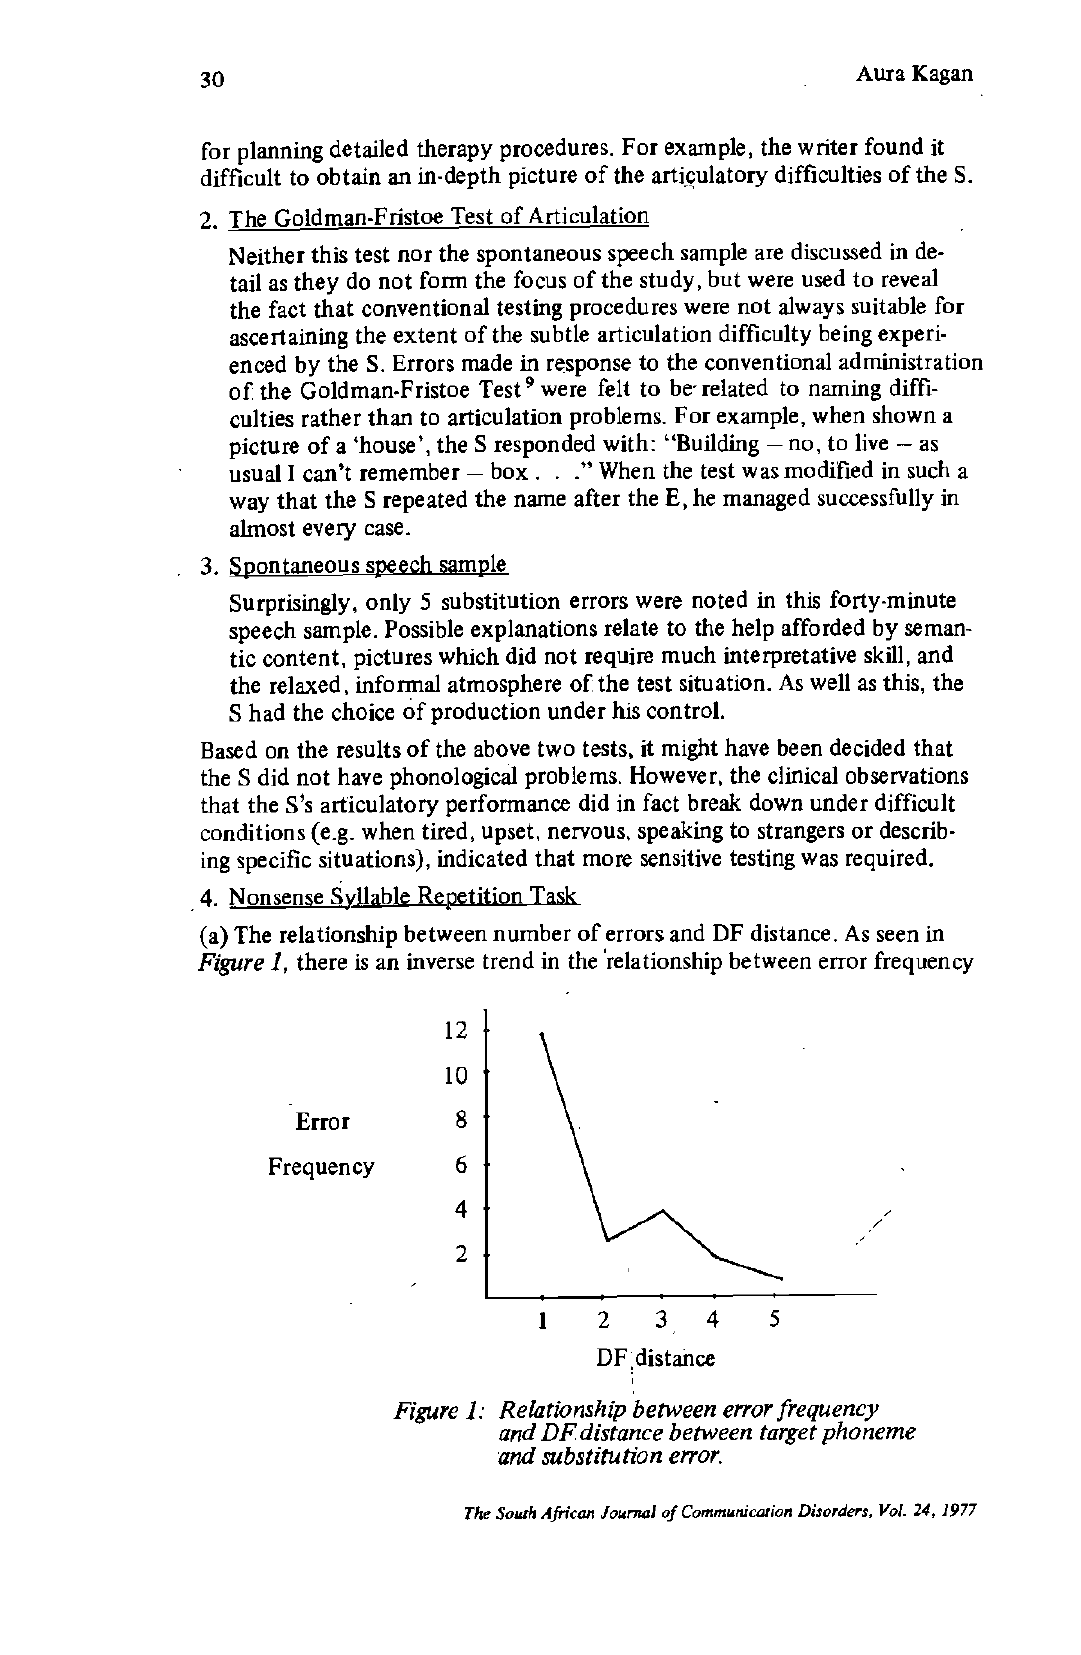
Figure 1: Relationship between error frequency and DF distance between target phoneme and substitution